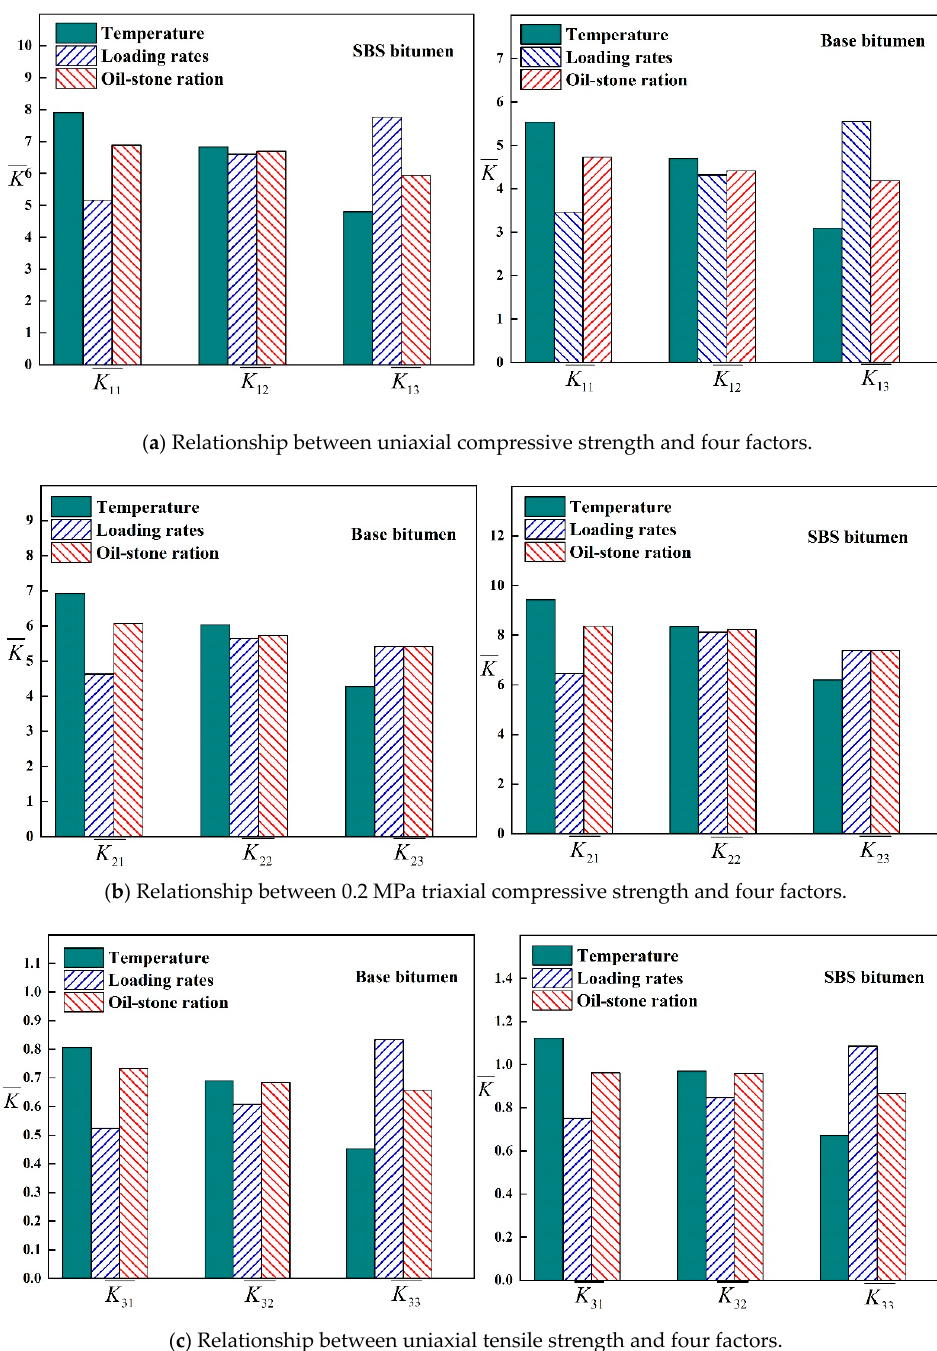
Figure 15. Three-factor range analysis.